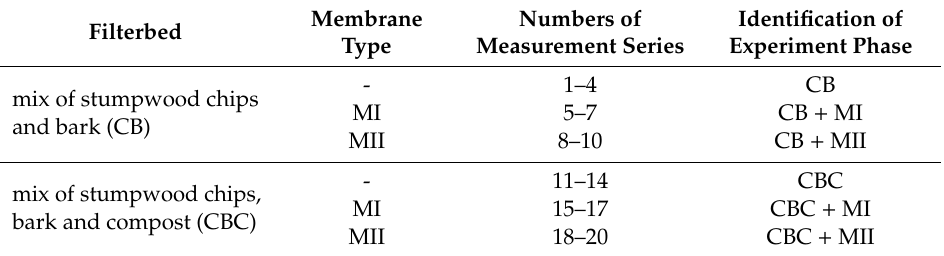
Table 1. Comparison of measurement series in particular phases of the